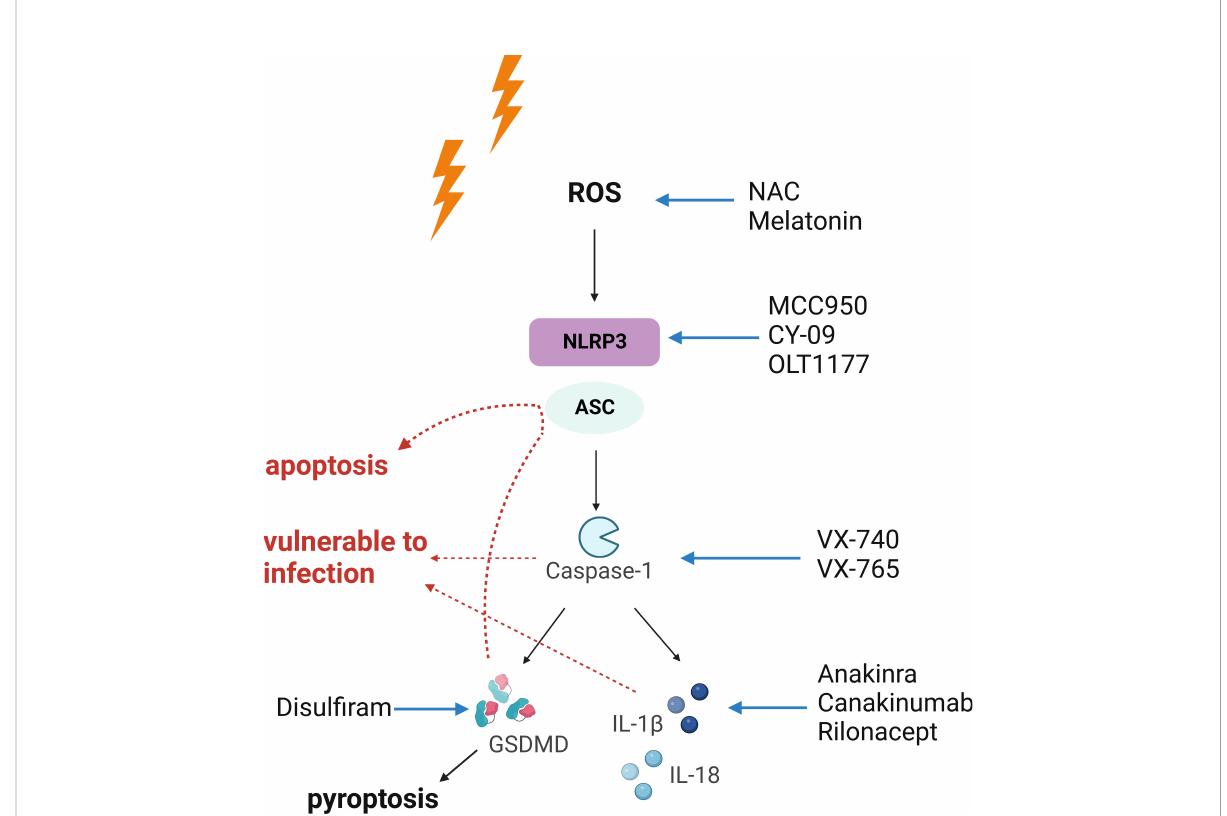
FIGURE 2 The necessity of early intervention against radiation-induced injury. The NLRP3 in fl ammasome acts as an executioner in radiation-induced tissue injury. Upon activation, it triggers a cascaded reaction, which indicates that interventions targeting upstream of the signaling may yield the most desirable outcomes. In comparison, the results of downstream intervention may be accompanied with unwanted effects. Red arrows indicate unwanted effects of strategies suppressing pyroptosis, caspase-1, or IL-1 b . Blockade of pyroptosis may lead to activation of apoptosis or other death pathways. Also, caspase-1 is required for the proper function of other in fl ammasomes, and blockade at this point may shut down the entire in fl ammasome signaling, leaving the organism vulnerable to infection. Suppressing IL-1 b also increases the risk of infection. Both Figures 1, 2 were created with